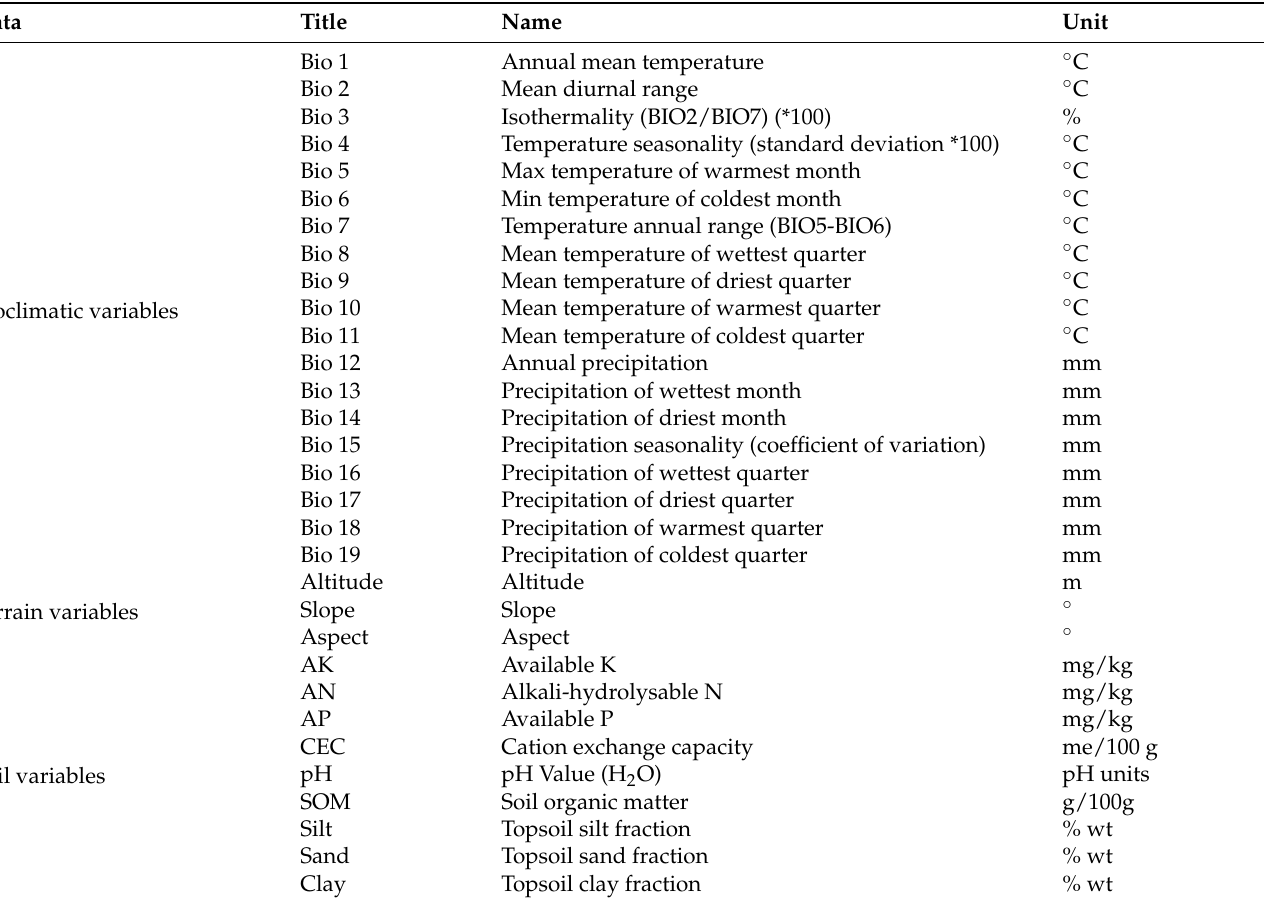
Table 1. Environmental indicators used in this paper to model the potential distribution of Arabica coffee